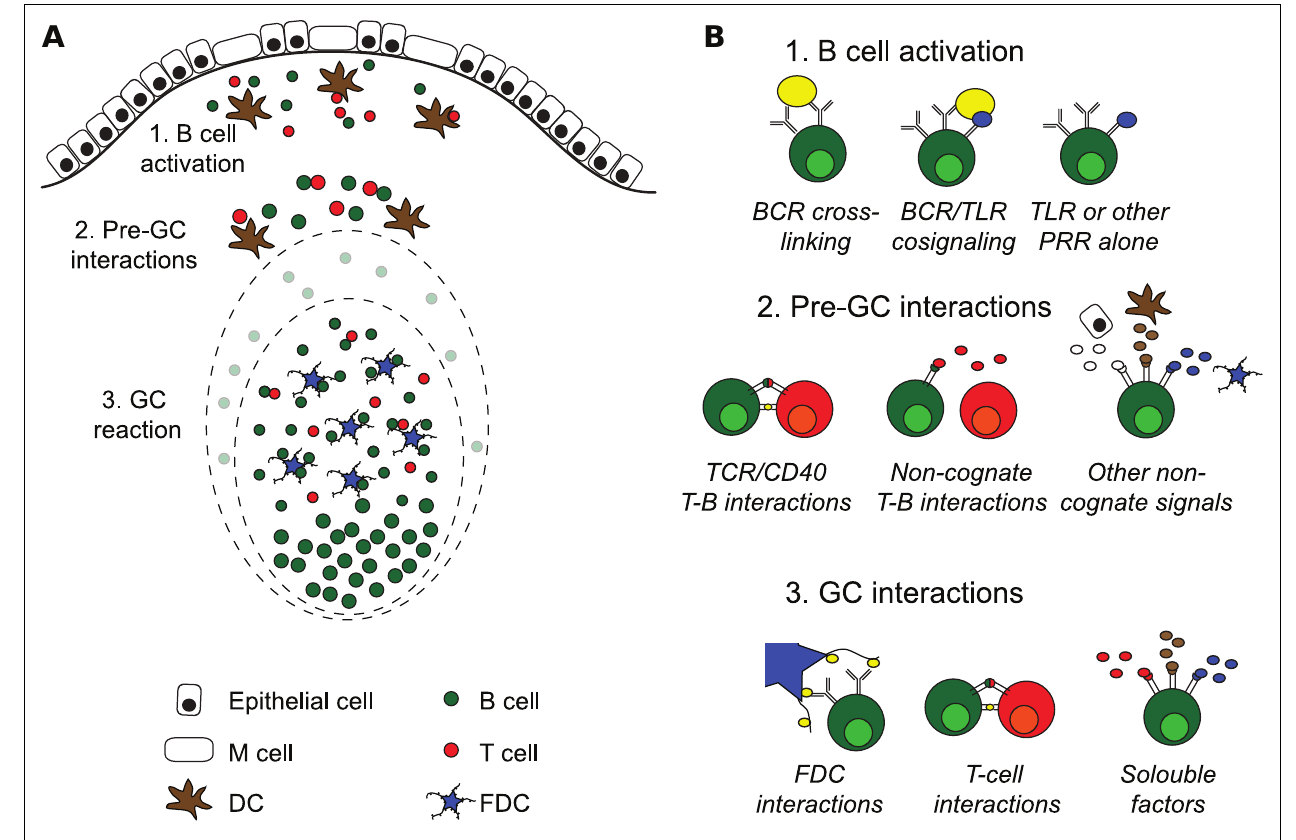
FIGURE 1 |Activation of B cells and germinal center formation in Peyer’s patches. (A) IntestinalT cell-dependent antigens enter the gut via the oral route or are locally produced by the gut microbiota. Peyer’s patches (PP) are covered with a specialized follicle-associated epithelium hosting M cells that can transport antigen into the subepithelial dome. Here, B cells and DC encounter antigen, leading to B andT cell activation. After interactions with cells and soluble factors outside of the germinal centers (GC), B cells enter into preformed GC where they proliferate and expand before seeding the gut with IgA producing plasma cells. (B) SystemicT cell-dependent responses strictly rely on two signals, antigen cross-linking andTCR/CD40 mediated cognate interactions with antigen-specificT cells, before de novo GC formation take place. After that, the cells are dependent on direct interaction with follicular dendritic cells (FDC) andT cells in addition to soluble factors in